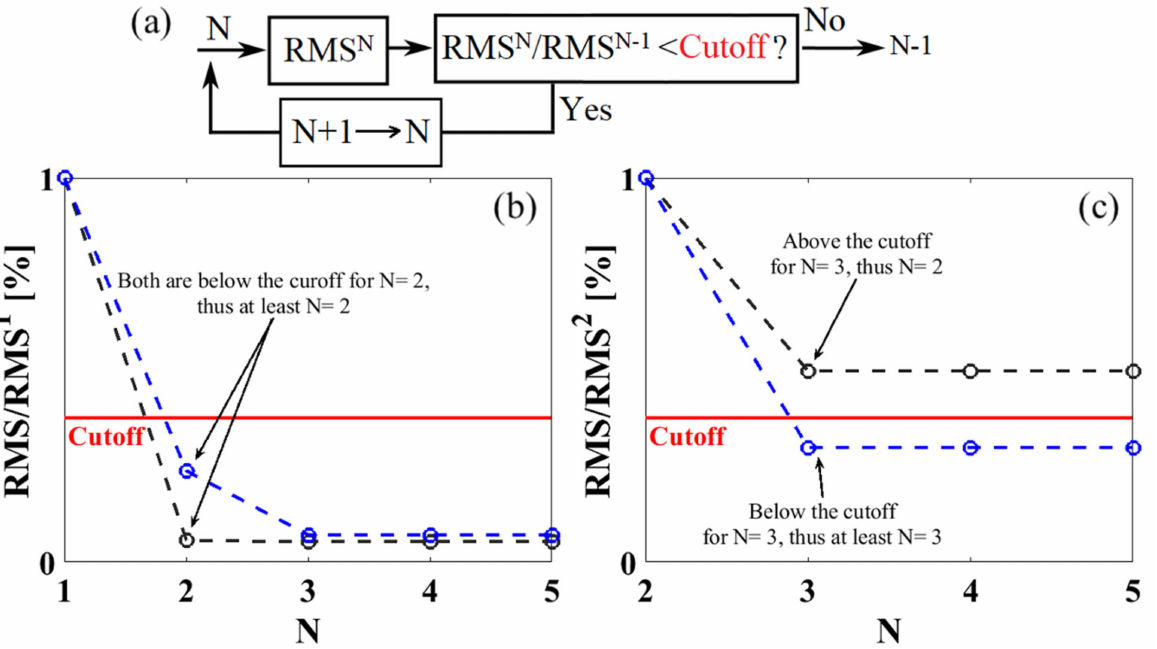
Figure 7. Depicting a decoding method based on using the fitting quality (RMS) as an indicator for determining the number of nanobarcodes at the readout, ( a ) a flowchart for decoding and ( b , c ) data analysis for finding the number of the nanobarcodes were produced. The algorithm assumes that one (N = 1) nanobarcode exists, thus, it fits the data with one Gaussian function and calculates the RMS1. Then, it increases N to two, and it calculates RMS2. If the RMS2/RMS1 ( b ) is larger than the cutoff value, there was only one nanobarcode at the readout. Otherwise, there are at least two nanobarcodes and the procedure must be repeated for N=3, which means RMS3/RMS2 must be evaluated ( c